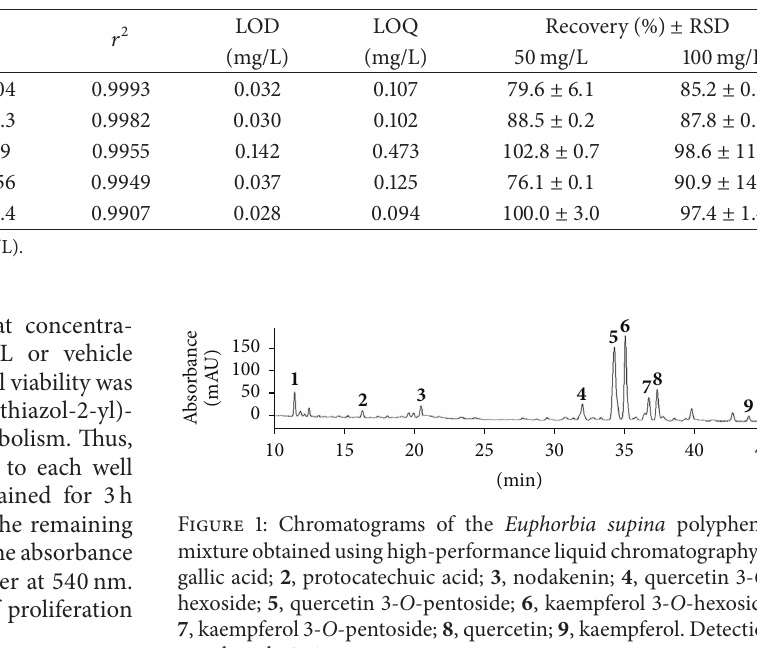
Nine polyphenols were labeled in the 10 to 45 min